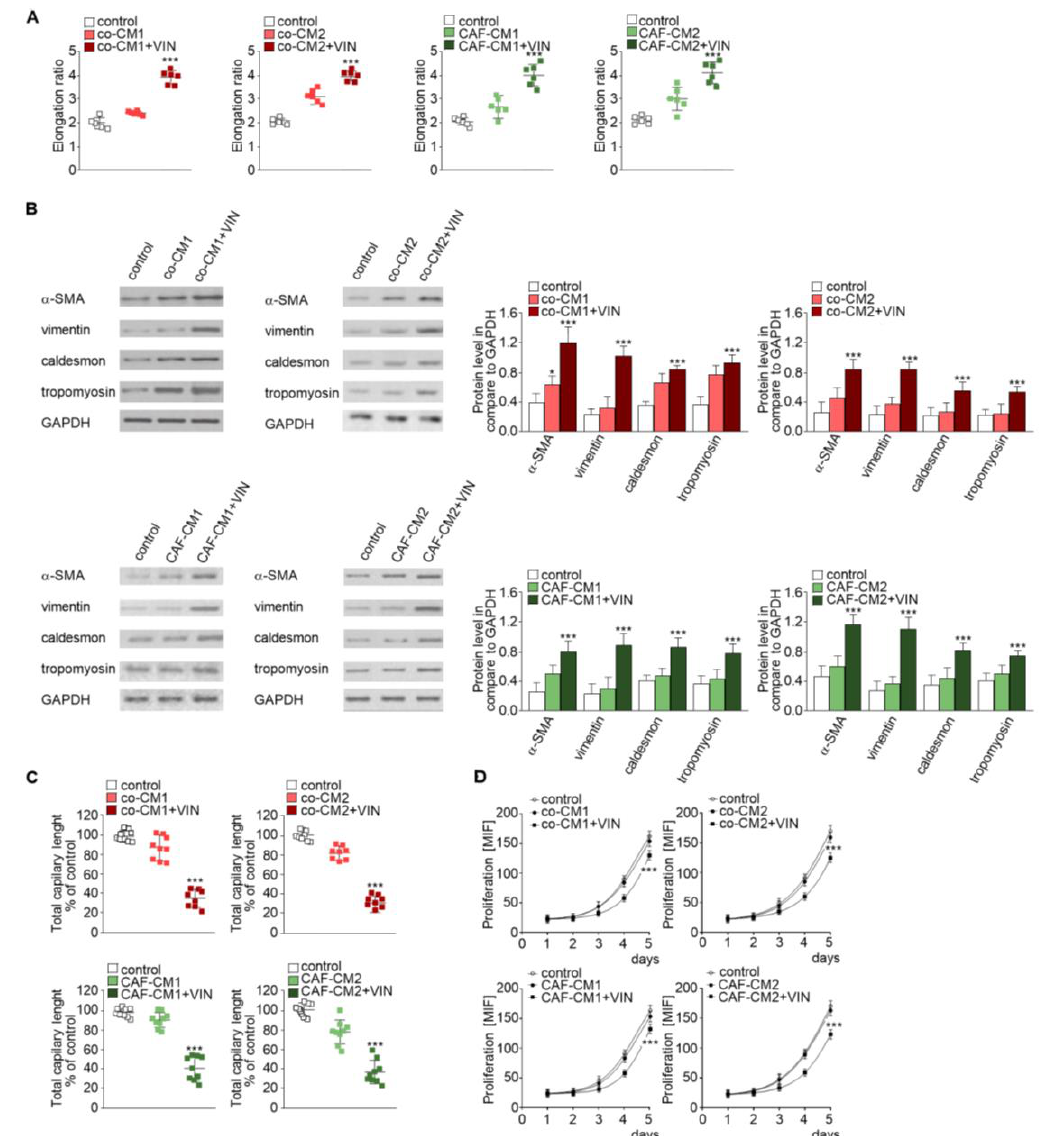
Figure 2. Mesenchymal transdifferentiation in HMEC-1 is modulated by vincristine-treated CAF-like cells. HMEC-1 cells were cultured in medium supplemented with CM isolated from coculture of CAF-like cells and colon cancer (LS180—co-CM1 or LoVo—co-CM2) or CAF-like cells maintained in CM colon cancer cells (LS180—CAFs-CM1 or LoVo—CAFs-CM2) and treated, if necessary, with vincristine ( + VIN). Then, elongation ratio ( n = 6) ( A ), level of contraction proteins (caldesmon, tropomyosin), vimentin, and α -SMA (Western blot) ( B ), capillary assay ( n = 9) ( C ), and proliferation ability ( D ) were analyzed. In Western blot assay, GAPDH was used as the loading control. The results are provided as means ± SD ( n = 3); * p < 0.05, *** p < 0.005. The blots are representative of three independent experiments.